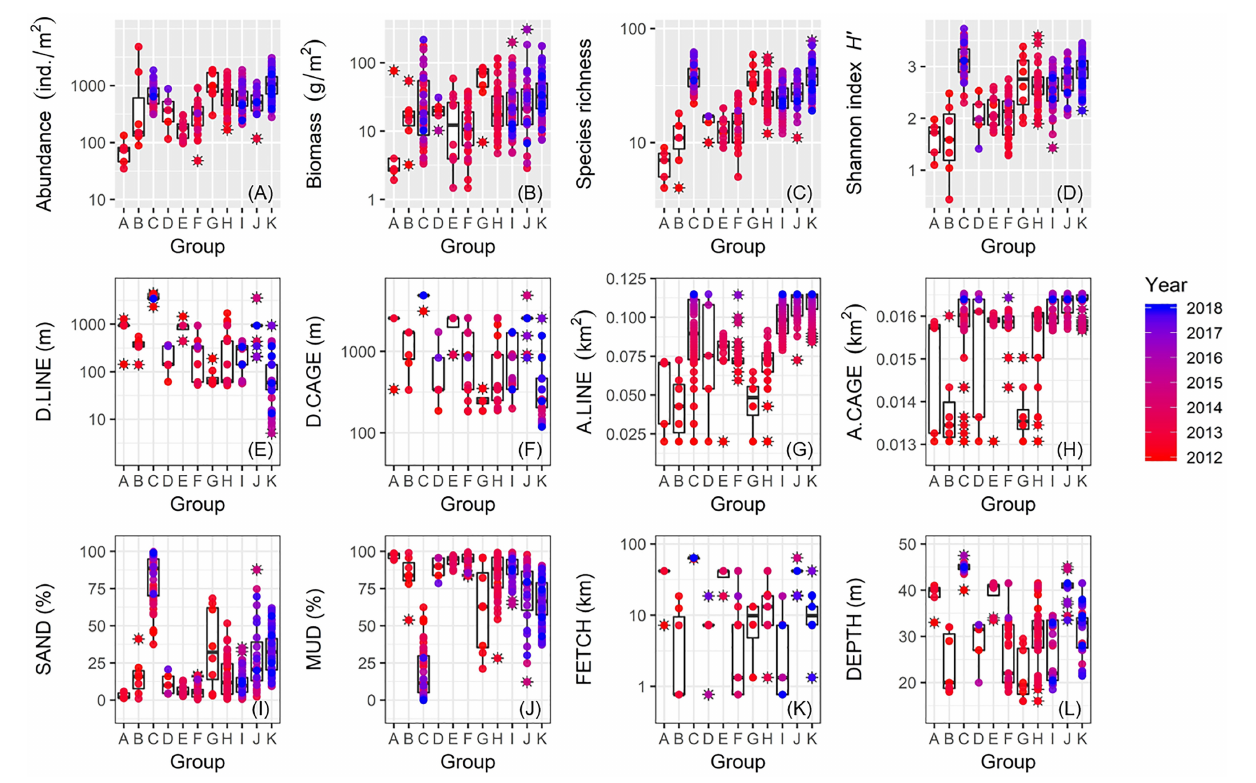
FIGURE 9 | Box plots showing between-group comparisons of macrofauna and environmental data for: (A) abundance; (B) biomass; (C) species richness; (D) Shannon’s index H (cid:48) ; (E) D.LINE; (F) D.CAGE; (G) A.LINE; (H) A.CAGE; (I) SAND; (J) MUD; (K) FETCH; and (L) DEPTH (coding of environmental variables as in Table 1